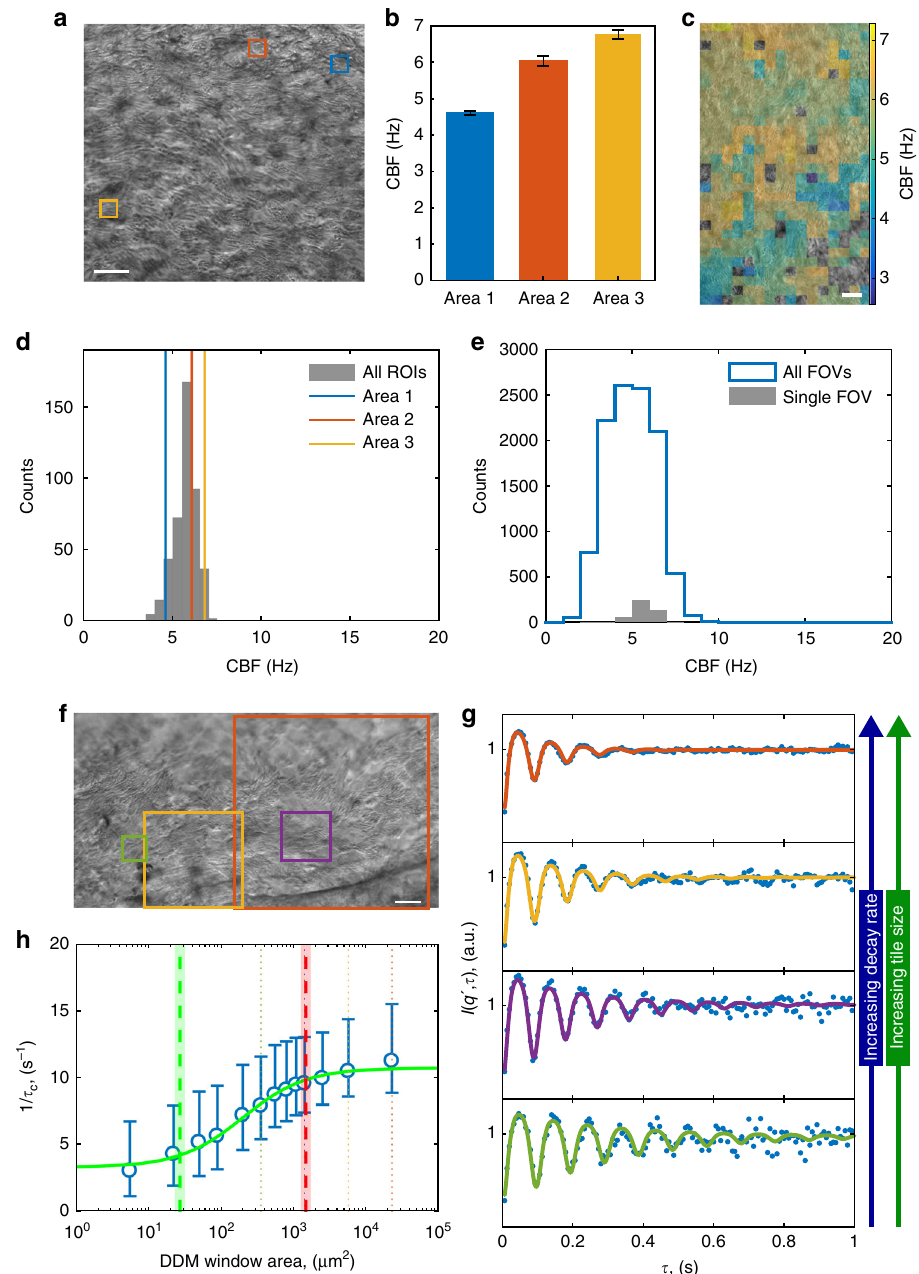
Fig. 1 Quantitating ciliary beat dynamics in healthy HAECs via multi-DDM. a Example image from a microscopy video showing three different 64 × 64 pixel regions (red, blue and yellow) selected for CBF analysis. Scale bar is 20 μ m. b Values of CBF in the regions highlighted in a . CBFs differed among the regions, highlighting that measuring CBF only in user-selected ROIs is not suf fi cient for an unbiased and comprehensive measurement. c The division in tiles of an FOV, and their measured CBF (in false colours). This yields the full distribution of CBF in this FOV ( d ). CBF measurements from the 3 ROIs of a , b are shown with vertical lines. e A more exhaustive measurement of an ALI sample ’ s CBF can be obtained by imaging several FOVs scattered around the insert, and aggregating the CBF distributions from all such FOVs (blue outline). In grey, as a comparison, the CBF distribution as in d . To measure the coordination length scale of beating cilia, we fi rst divide each FOV into tiles, repeating this process while systematically increasing the size of the tiles. DDM is run on each tile. For example, f shows the outline of four tiles, each of a different size. As detailed in ref. 7 , the output of DDM on motile cilia is an oscillating and decaying signal, examples of which are shown in g for each region shown in f . We fi t the experimental data (dots) with Eq. (2) (solid lines, colours matching the respective regions in f ) obtaining excellent agreement. The decay rate measures how poorly coordinated the motion within the analysed region is, and it increases with the tile size. Considering the median of the decay rate τ c − 1 (circles, whiskers showing 25th and 75th percentiles) measured at each tile area across several FOVs, one obtains a sigmoidal curve that quantitatively represents the length scale of ciliary coordination ( h ). The green and red dashed lines indicate, respectively, the left and right shoulders of the sigmoidal curve (shaded regions indicating the 68% con fi dence interval). Dotted lines report the area of the tiles highlighted in f in matching